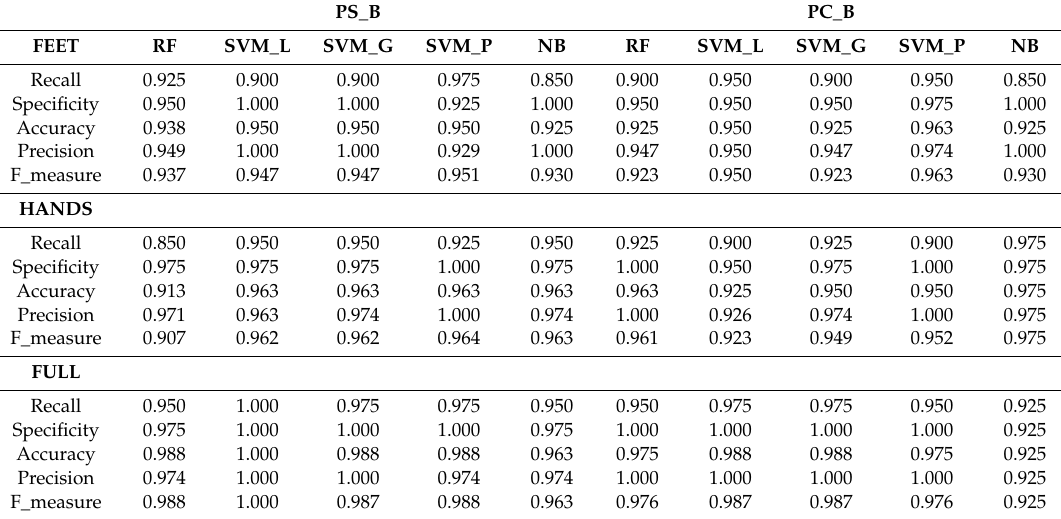
Table 6. Classification Results for Post-Significance and Post-Correlation datasets after Bonferroni